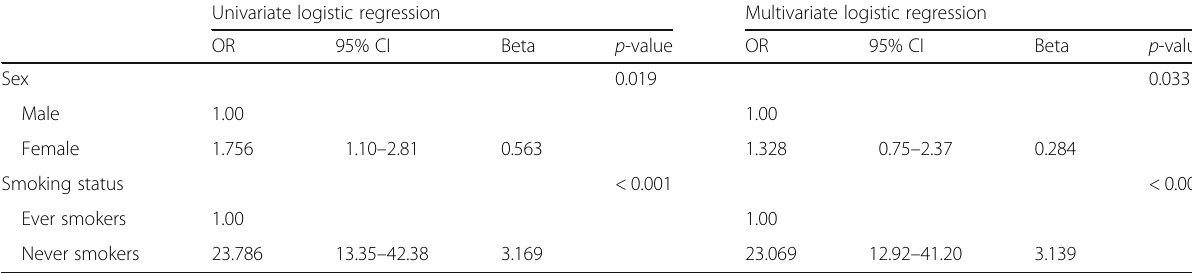
Table 4 Logistic regression analysis of EGFR mutational status Univariate logistic regression